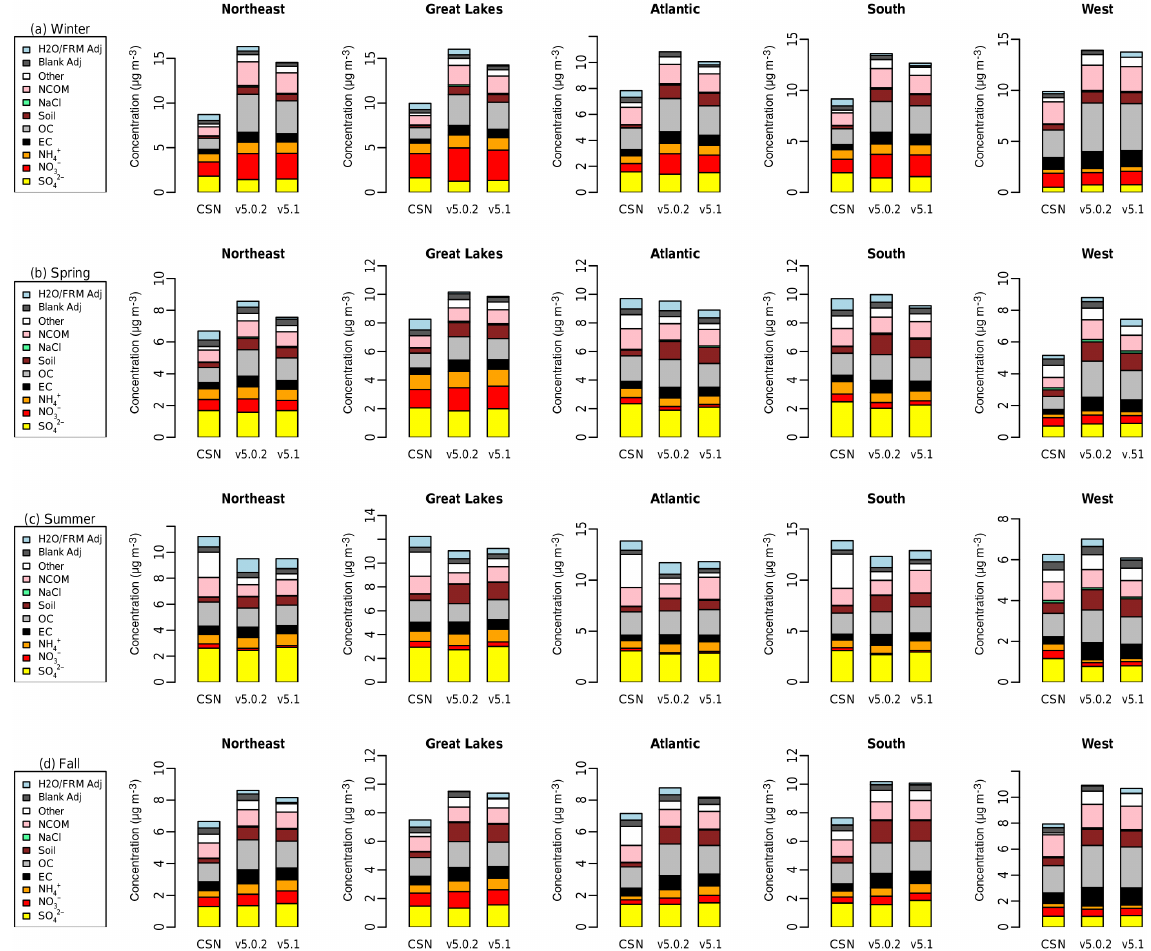
Figure 10. Regional and seasonal stacked bar plots of PM 2 . 5 composition at the CSN sites (left), CMAQv5.0.2_Base simulation (middle) and CMAQv5.1_Base_NEIv1 simulation (right). In order from top to bottom are (a) winter, (b) spring, (c) summer and (d) fall seasons and left to right the northeast, Great Lakes, Atlantic, south and west regions. The individual PM 2 . 5 components (in order from bottom to top) are SO 2 − (yellow), NO − (red), NH + (orange), EC (black), OC (light gray), soil (brown), NaCl (green), NCOM (pink), other (white), blank 4 3 4 adjustment (dark gray) and H 2 O / FRM adjustment